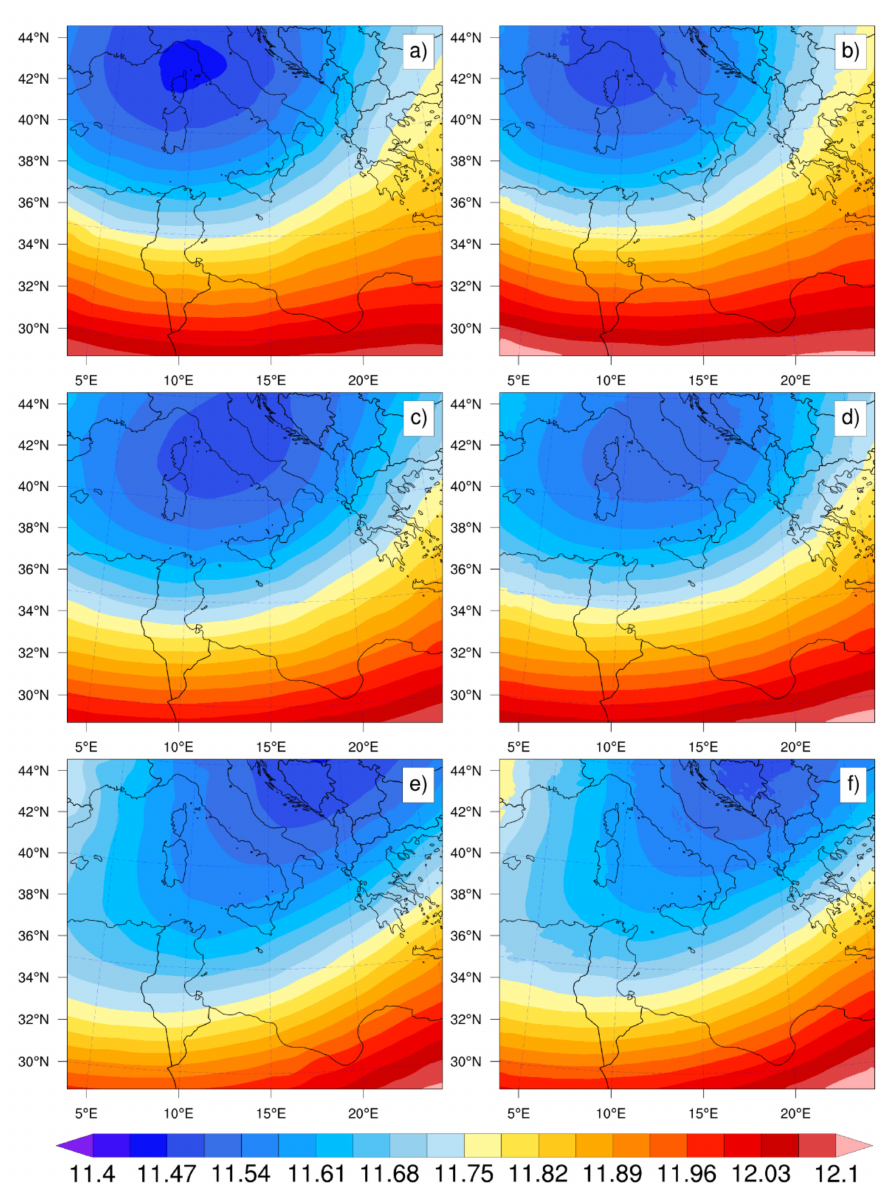
Figure 5. Geopotential at 200 hPa in km, panels ( a , c , e ) ERA5 reanalysis, panels ( b , d , f ) WRF-Chem. Top, middle and bottom rows at 12:00 UTC on November 23, 24, and 25,